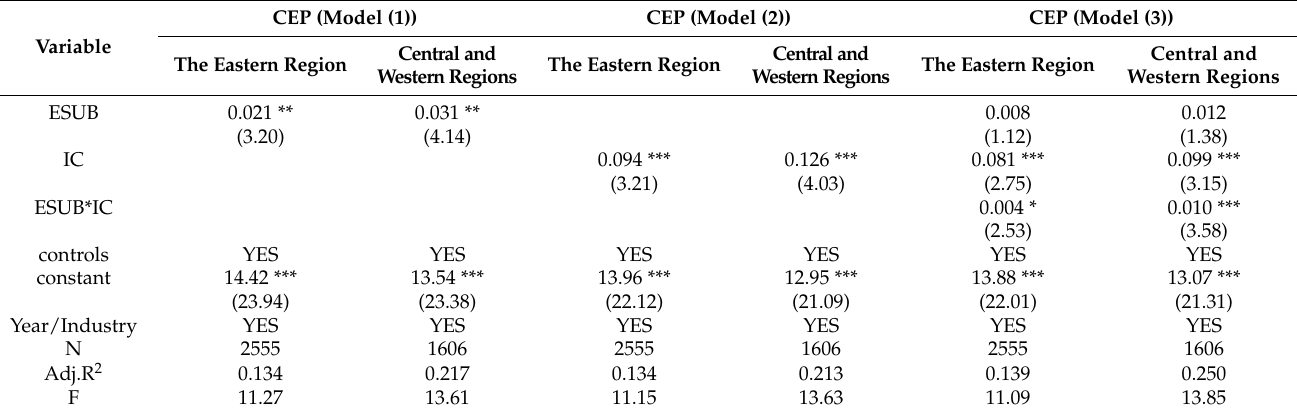
Table 4. Regression analysis of East and mid-west Enterprise